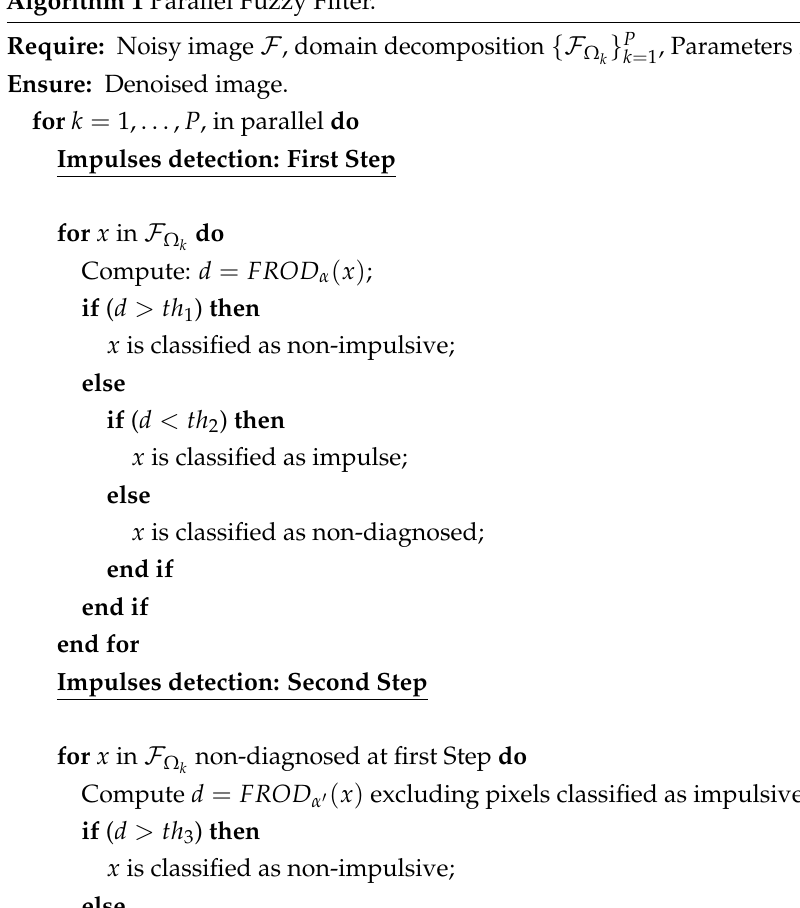
Algorithm 1 Parallel Fuzzy